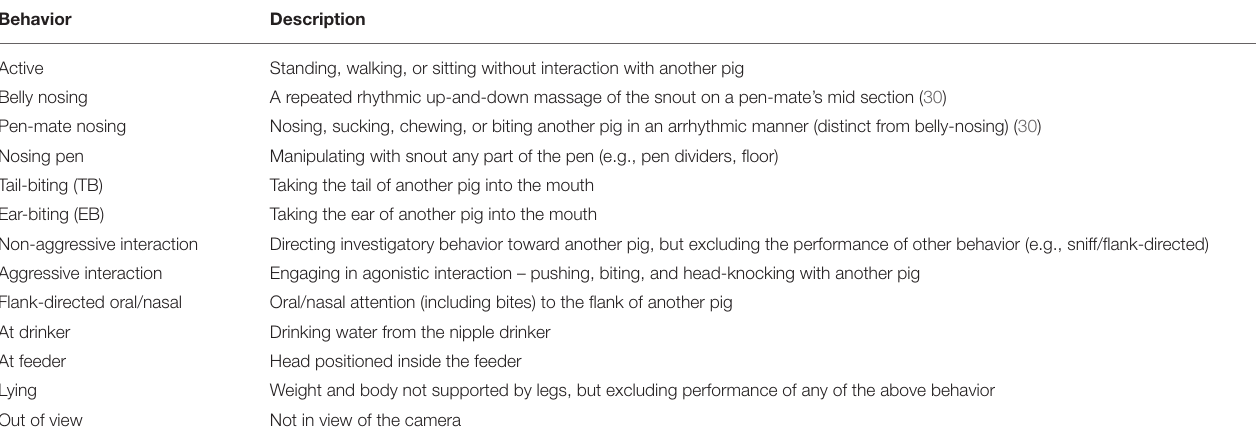
TABLE 3 | Ethogram used for behavior analysis for study #1 and study #2. Behavior